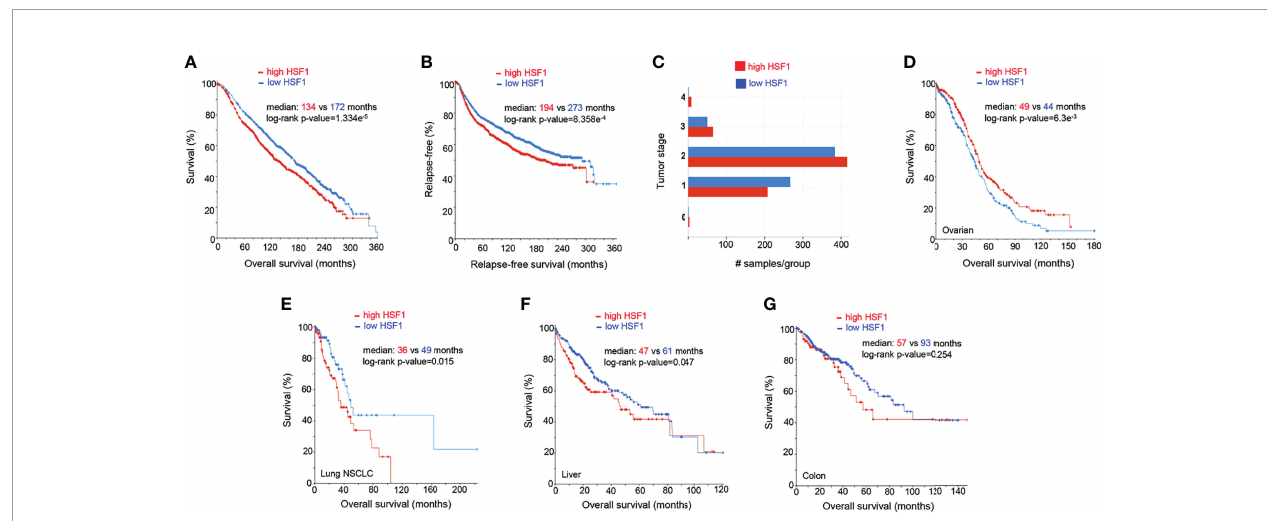
FIGURE 4 | Prognostic signi fi cance of HSF1 gene expression in selected human cancers. Patients were divided into groups with high and low expression of mRNA, signi fi cance level was de fi ned as p-value<0.05 in log-rank test. Each sample corresponds to an individual patient. (A) HSF1 mRNA expression and overall survival in breast adenocarcinoma patients (n=1903). (B) Relapse-free survival in breast cancer patients. Cut-off point was set at median expression. (C) Tumor stage in relationship to the HSF1 transcript levels. Higher HSF1 expression was associated with more advanced tumor stages, X 2 -test p-value= 1.93e -3 . (D) Overall survival in patients with ovarian serous cystadenocarcinoma (n=537) in relation to HSF1 mRNA expression. Cut-off point was set at median expression. Microarray data used in panels A-D was sourced and analyzed via cBioPortal (cbioportal.org) (165, 166). (E) Overall survival in non-small cell lung cancer (NSCLC, n=211), (F) Hepatocellular carcinoma (n=373), cut-off point was set at 0.5 SD above the mean expression. (G) Colorectal adenocarcinoma (n=379), HSF1 mRNA is not associated with survival. RNA Seq data used in panels E-G was sourced and analyzed via cBioPortal (cbioportal.org) (165,